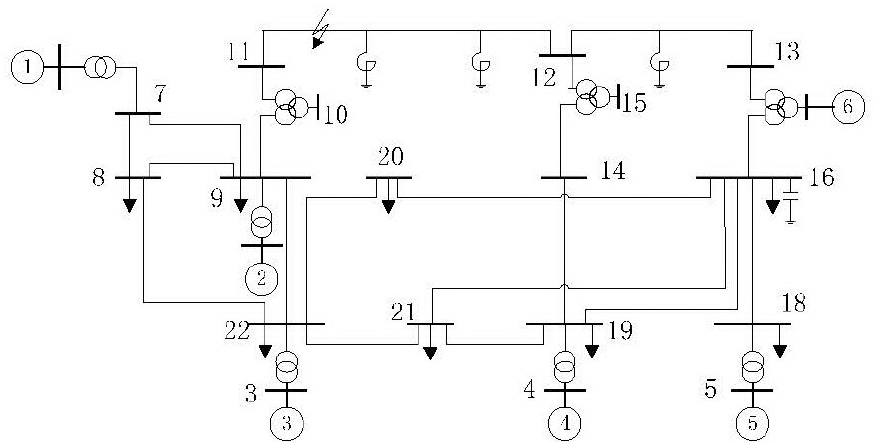
Figure 3. IEEE 22-bus